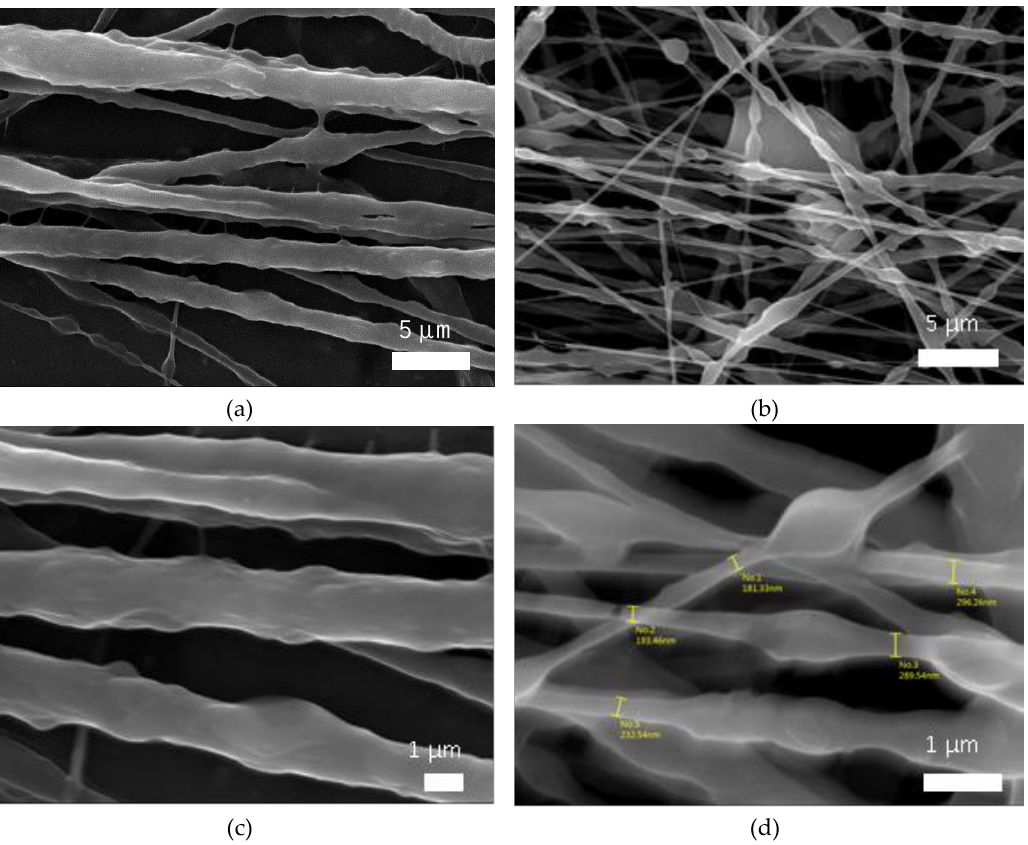
Figure 5. SEM images of aligned fibers of EM2 in the presence ( a , c ) and absence ( b , d ) of TrGO. The white circles indicate the presence of TrGO in the aligned fibers of EM2 ( d ). EM: electrospun mesh.